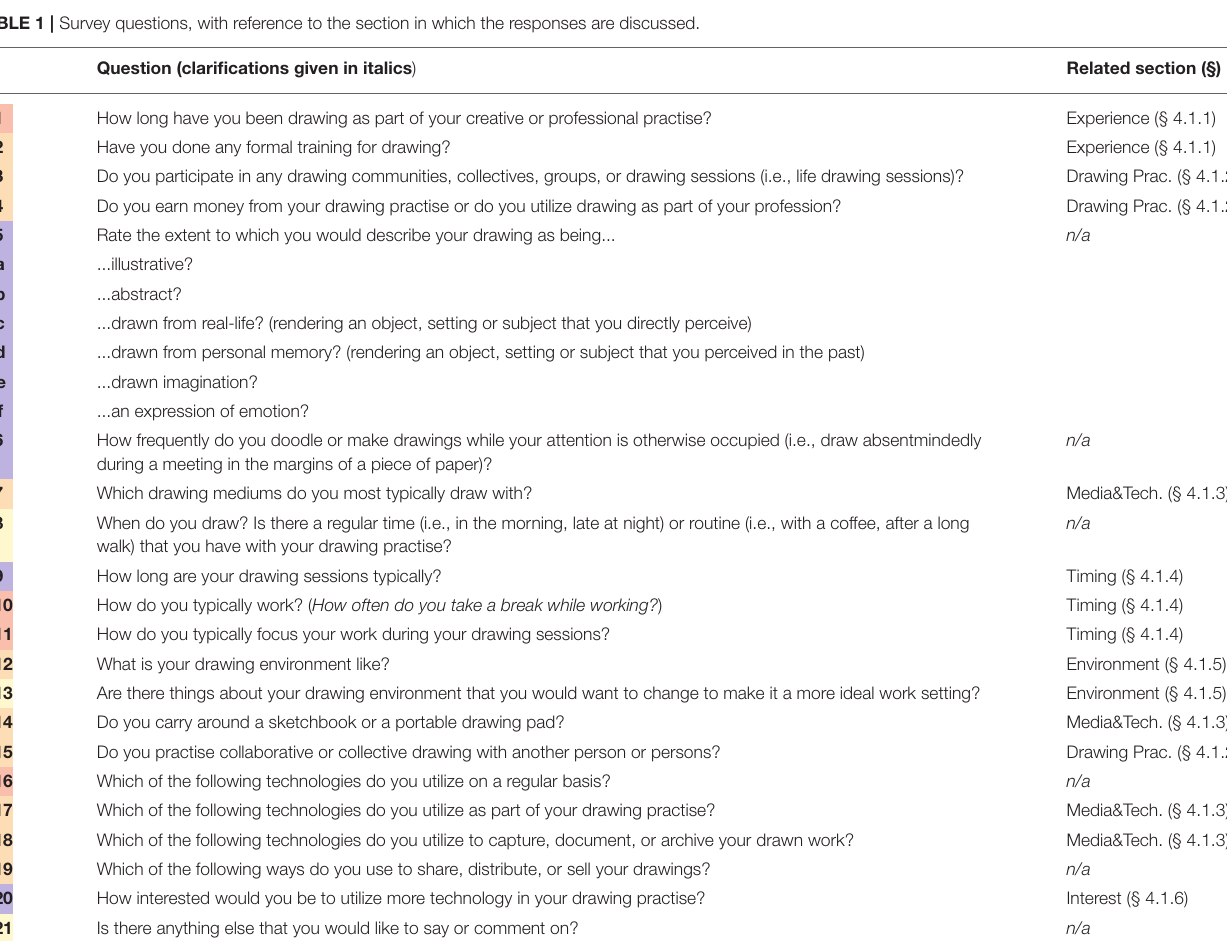
TABLE 1 | Survey questions, with reference to the section in which the responses are